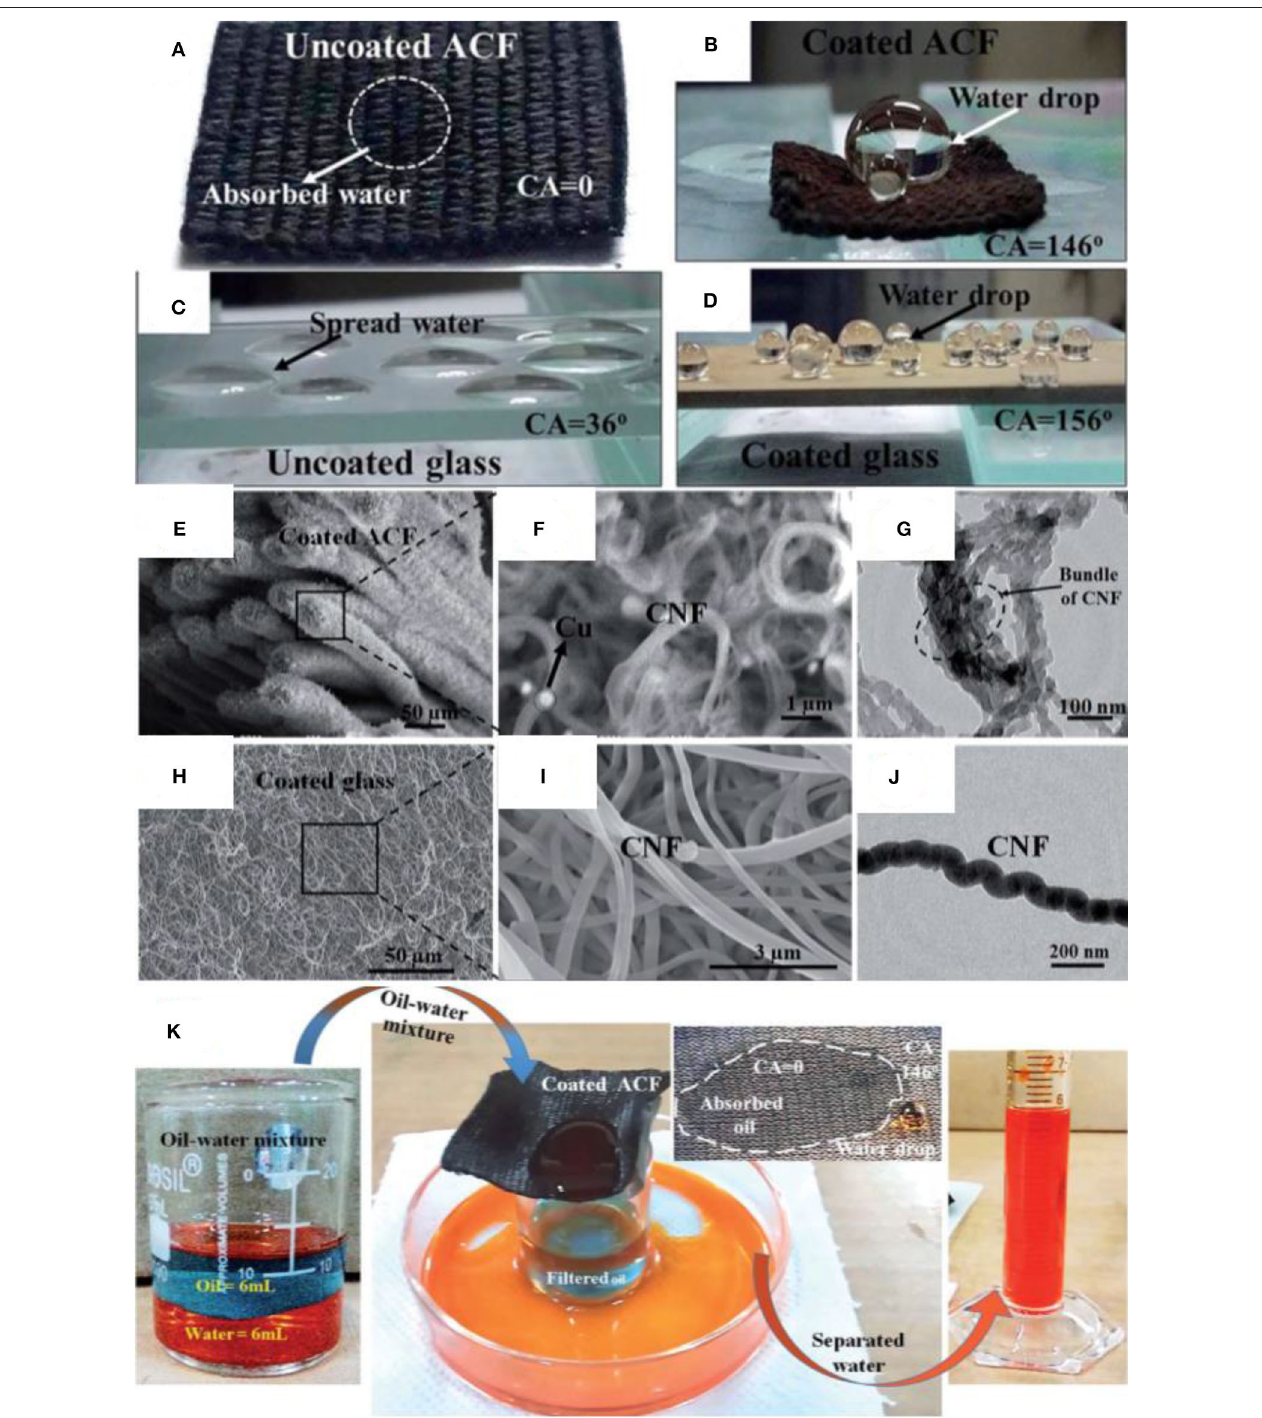
FIGURE 11 | (A) Digital images showing pristine ACF (B) and modified ACF (C) and pristine glass (D) and modified glass (E–J) . SEM and transmission electron microscopy (TEM) images of modified ACF and glass. (K) Separation of kerosene and water mixture by using modified ACF. Adapted from Siddiqui et al. (2017). With permission from the Royal Society of Chemistry, copyright